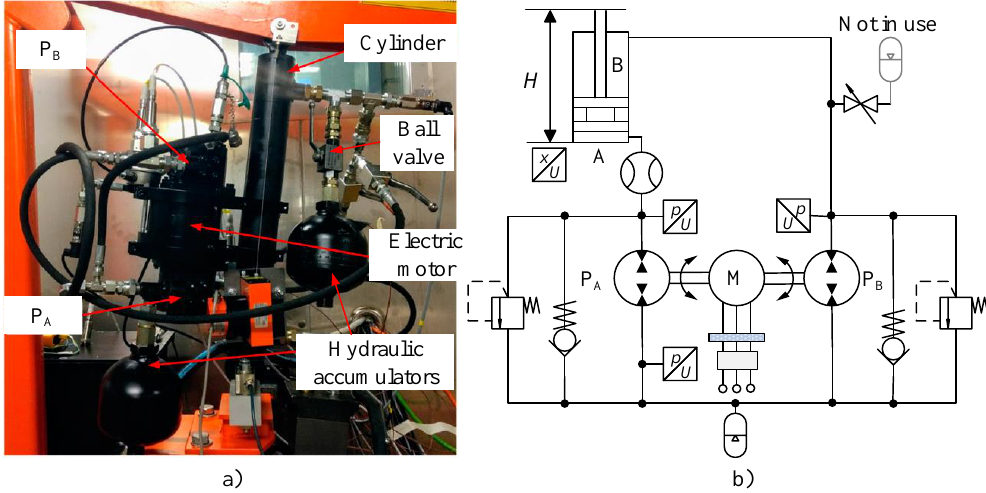
Figure 8. DPC installed on a crane for test: ( a ) picture of the test bench, ( b ) schematics of the test bench.